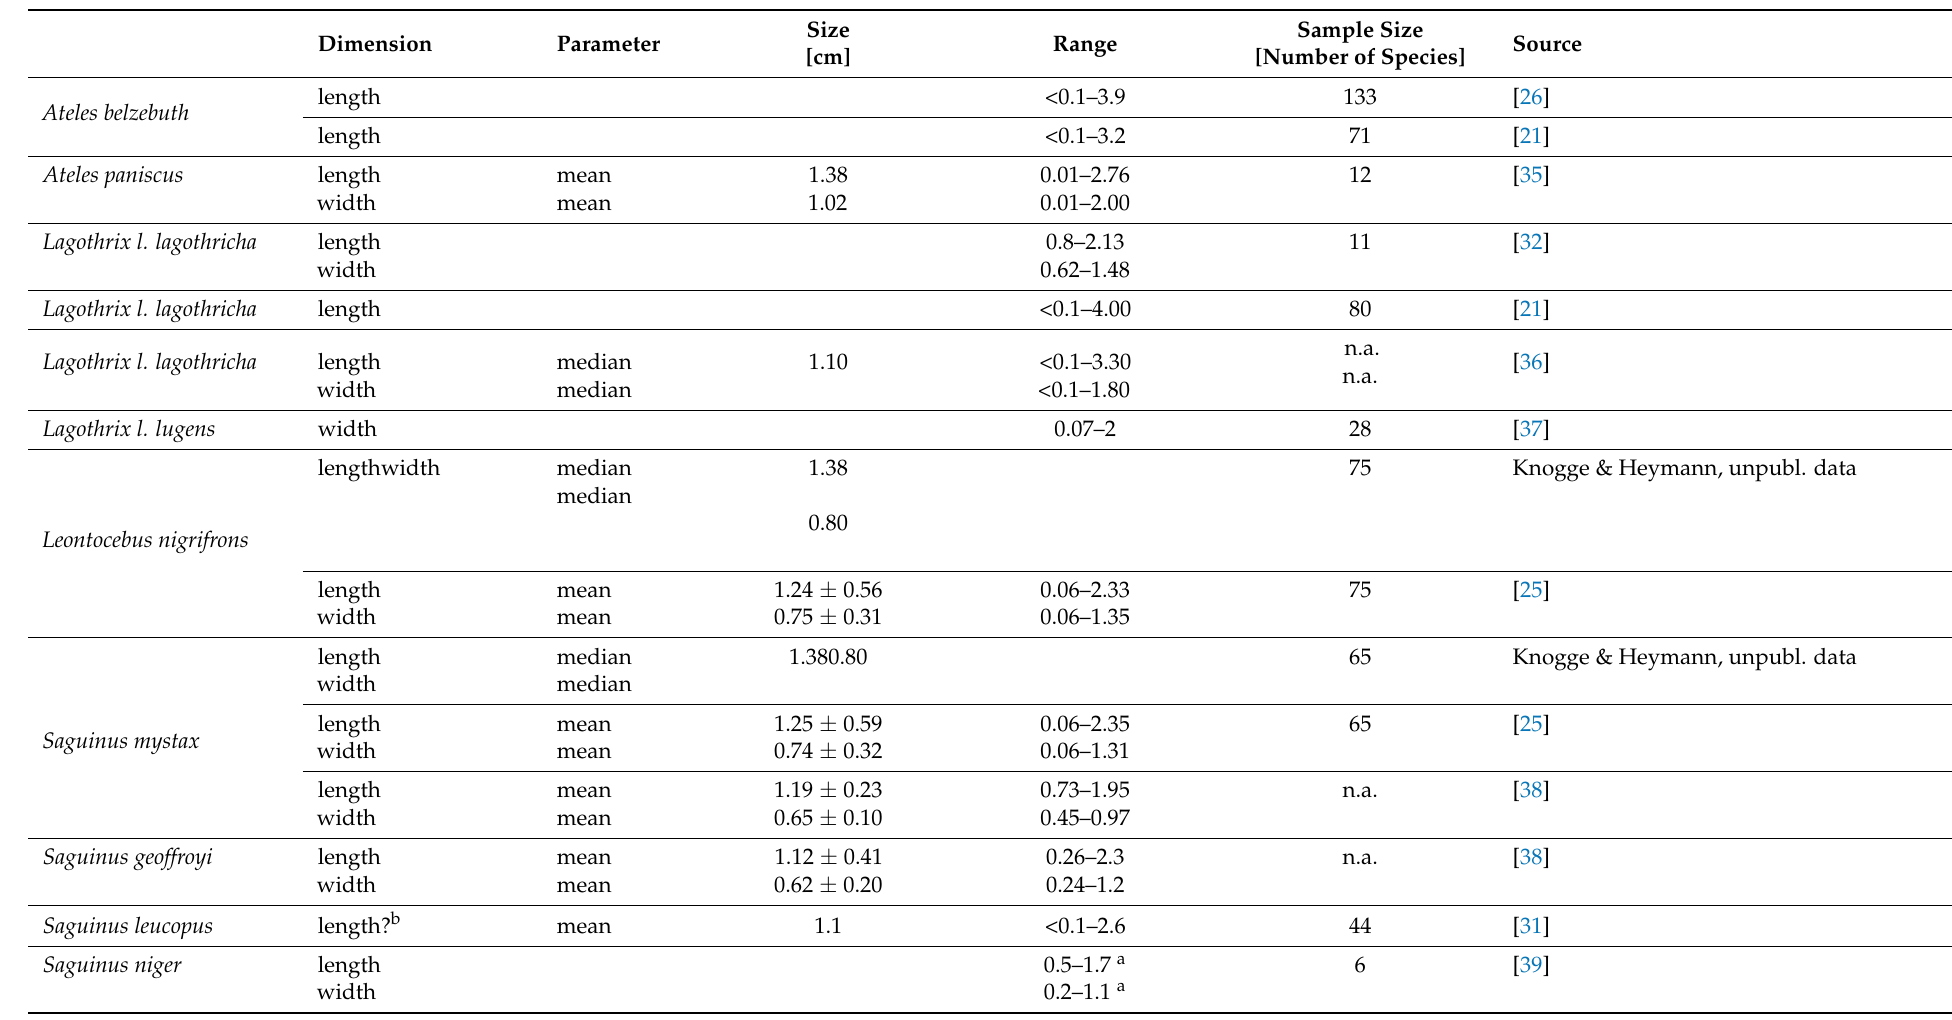
Table 4. Size of dispersed